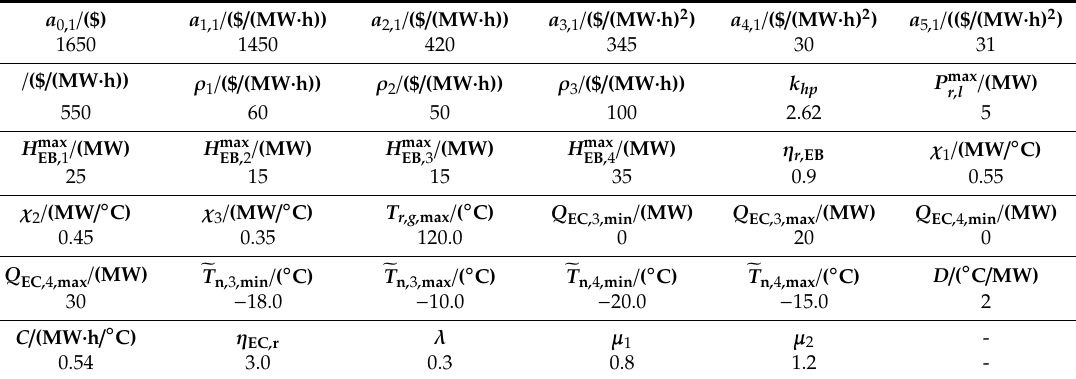
Table A4. Operating parameters of the IES.